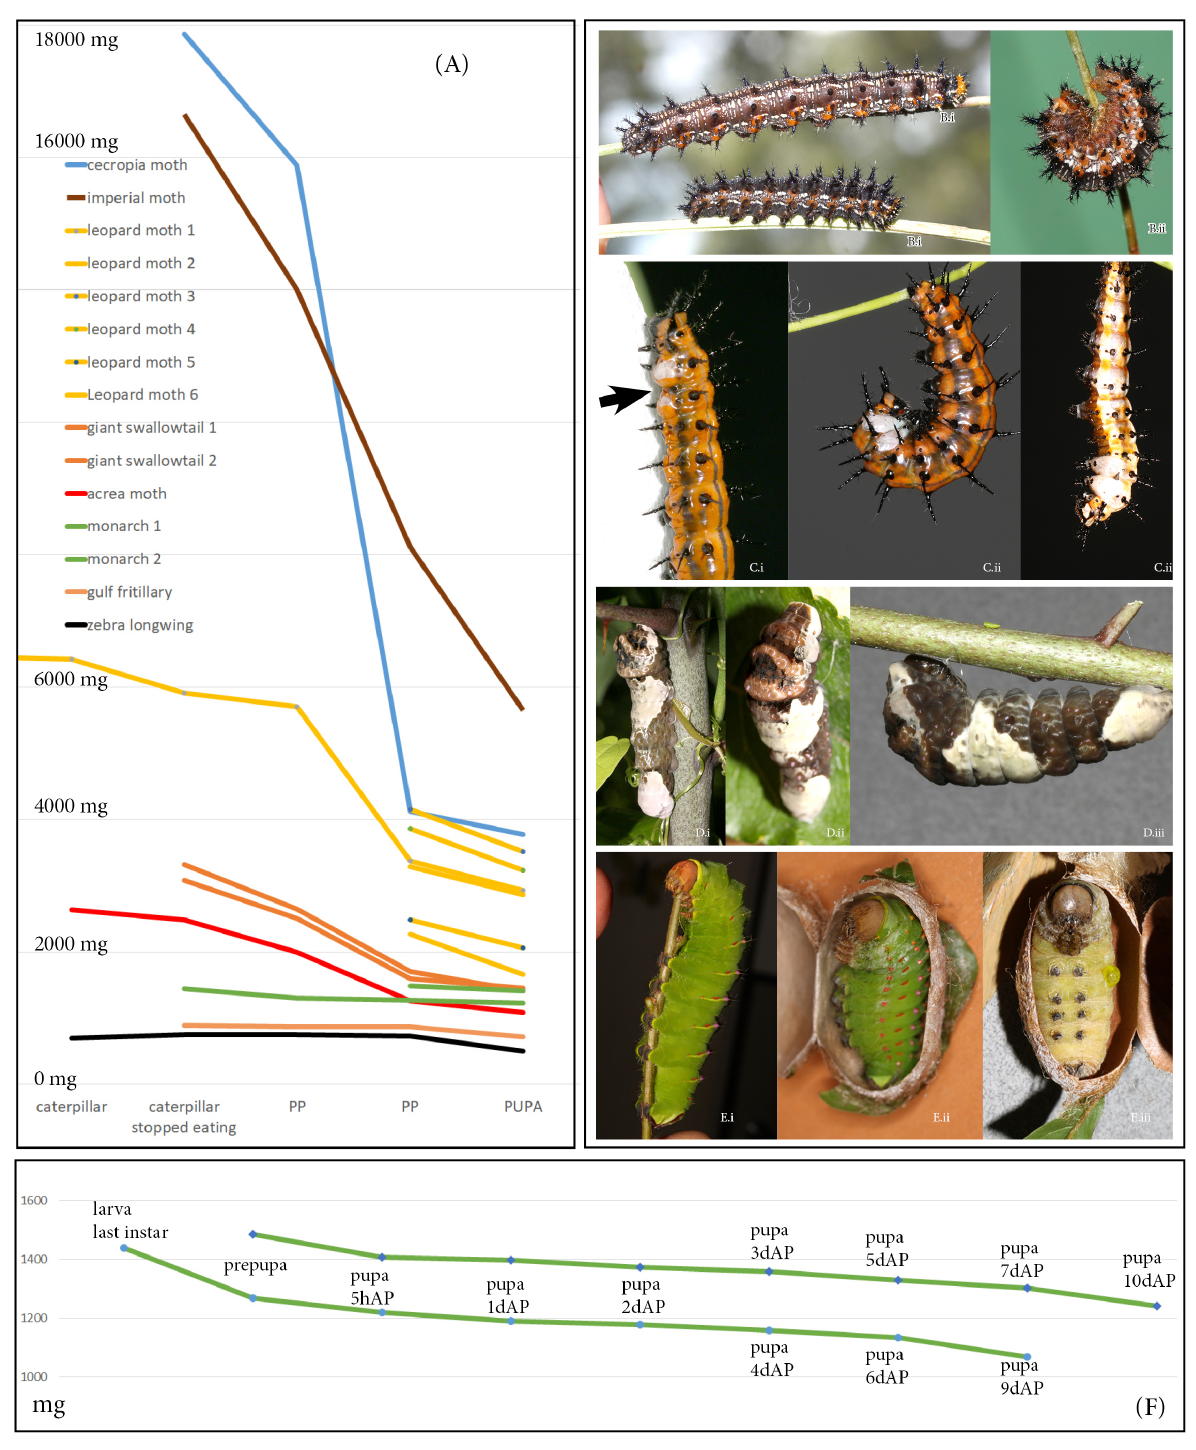
Figure 15. Weight loss by several representative butterfly and moth species during the transformation from late caterpillar stage to prepupa to pupa. ( A ) Drop in weight from the moment caterpillars stopped eating until pupation in 8 different Lepidoptera species shows sharper decline in moths compared to butterflies. The slope corresponds to species’ biology: moths spinning more silk lose relatively more weight than their counterparts from the same family that spin less silk. Six leopard moth individuals are included to illustrate intraspecific variation. ( B ) common buckeye, Junonia coenia ; ( C ) gulf fritillary, Agraulis vanillae ; ( D ) giant swallowtail, Heraclides cresphontes ; ( E ) polyphmemus moth, Antheraea polyphemus . ( i ) caterpillar at the end of feeding, ( ii ) early prepupae, ( iii ) late prepupae. ( F ) Decline of weight in two individuals of monarch, Danaus plexippus , from the end of feeding in caterpillar until day 10 of the pupal stage.